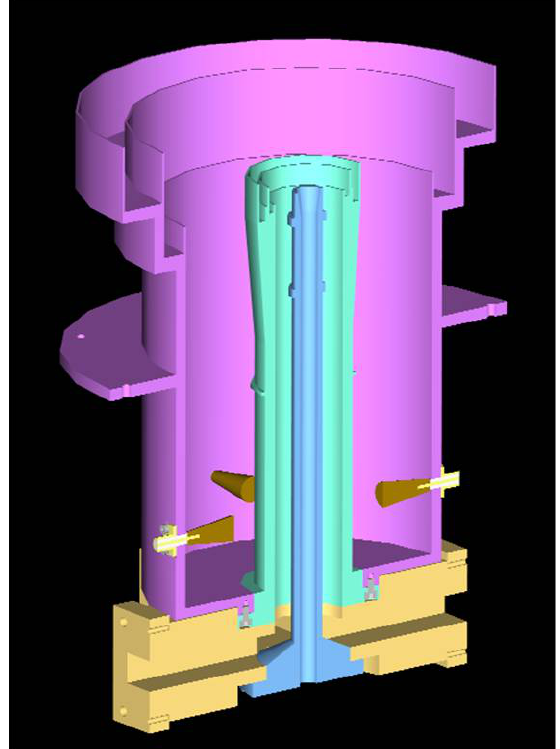
Figure 4. Internal view of tri-band receiver feed. The septum polarizer can be seen in Figure 5, where lateral coaxial connectors are for RCP and LCP outputs and front coaxial connectors are for calibration signal injection into the RCP and LCP chains. The circular waveguide port (top) connects to the Ka-band feed.